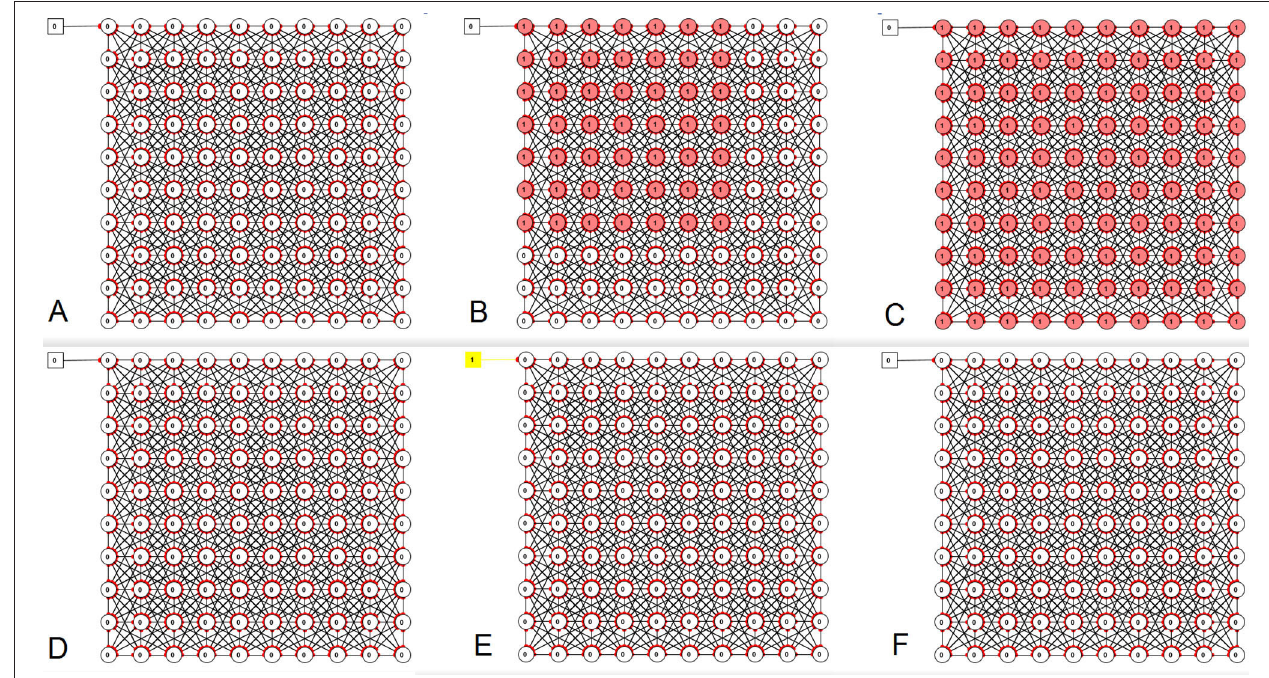
FIGURE 3 | Use of Simbrain 3.0 to simulate infection spread among interconnected individuals. Notice that the current parameters have not been carefully calibrated against any particular real-life situation and should be considered rough first estimates used for illustration purposes. It can be seen that models can easily be found in which a relatively minor change in the transmissibility can have dramatic effects on the system. It can also be demonstrated that for many systems, which could be achieved with masking combined with a set of other interventions, it is impossible or almost so to achieve a wave of infection transmission in the system. Red color shows those nodes that are active (i.e., exhibiting neuronal activity of being infected). Upper row (A–C) : Coupling between neurons 10% increased to enable a wave of infections to move through the system. Lower row (D–F) : With 10% reduced coupling between individuals, it is very difficult to elicit a wave of infections in the same system, all other parameters are equal. (A/D) , (B/E) , and (C/F) show three sequential time